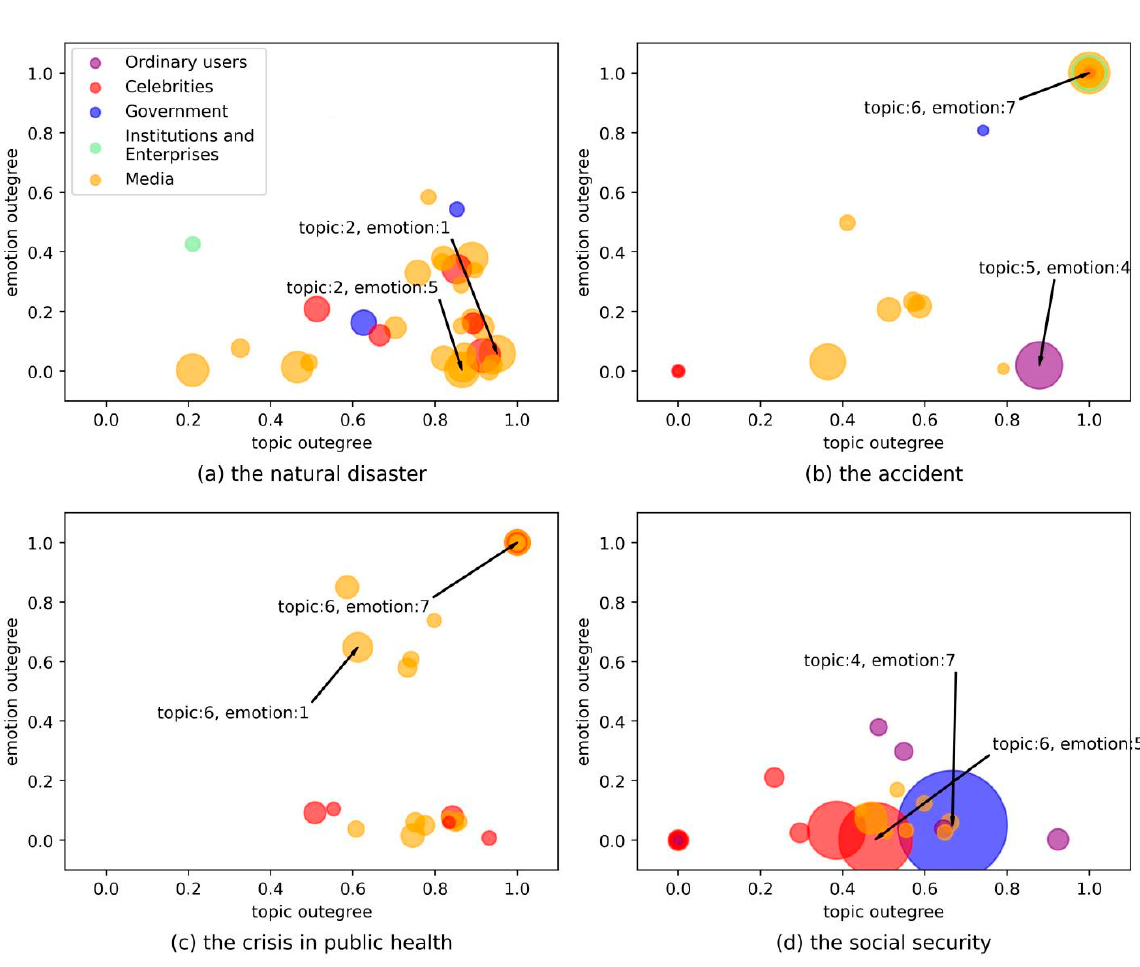
Figure 6. The topic out-degree and emotion out-degree of main user types.